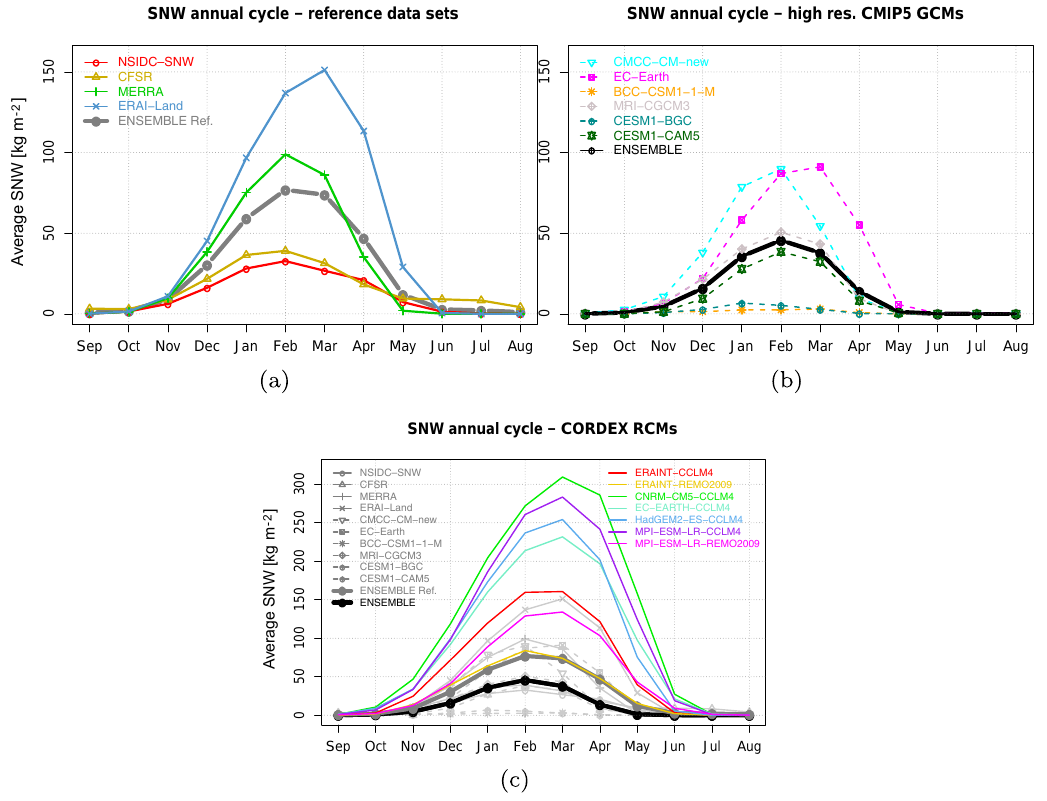
Figure 6. (a) Annual cycle of snow water equivalent in the reference data sets and (b) in CMIP5 high-resolution GCMs (spatial averages over areas above 1000ma.s.l., temporal averages over the historical period 1980–2005). (c) Annual cycle in ERA-Interim-driven and GCM-driven regional climate model simulations, calculated over the period 1990–2005, in comparison to reference data sets and GCM simulations.